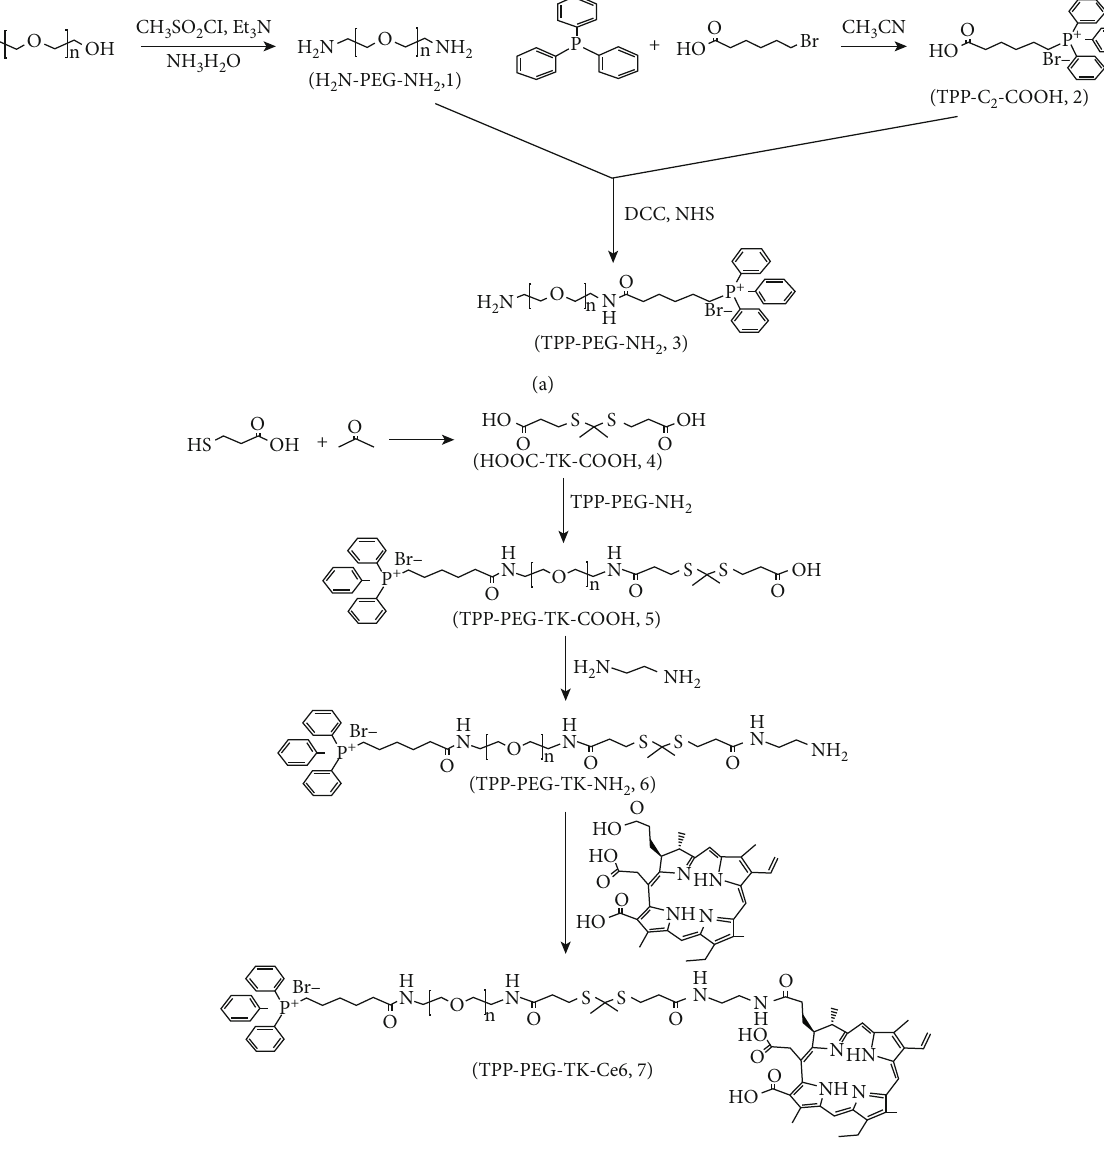
(a), HOOC-TK-COOH (b), and the amphiphilic copolymer of TPP-PEG-TK-Ce6 2